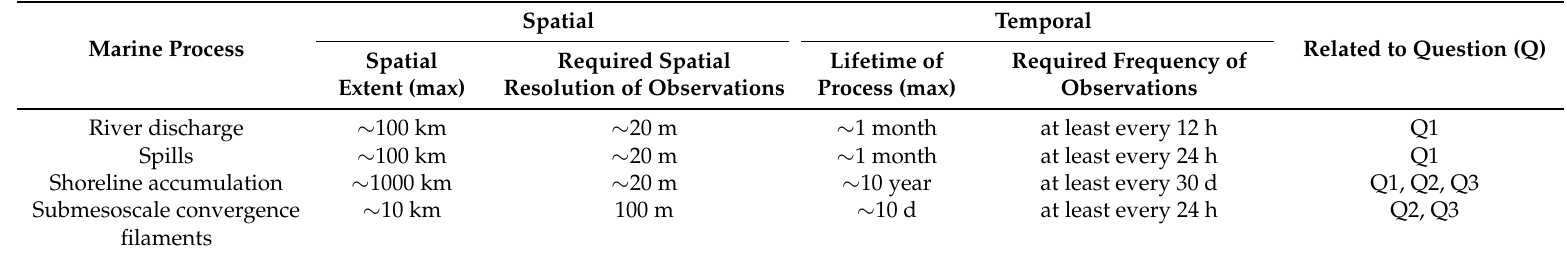
Table 1. Major marine processes affecting the fate of marine plastic debris and their relevance to identified scientific questions (See the Introduction section). Spatial extent and lifetime of processes are reported alongside corresponding spatial and temporal sampling requirements [44]. Sampling requirements are reported in terms of threshold levels, see text for